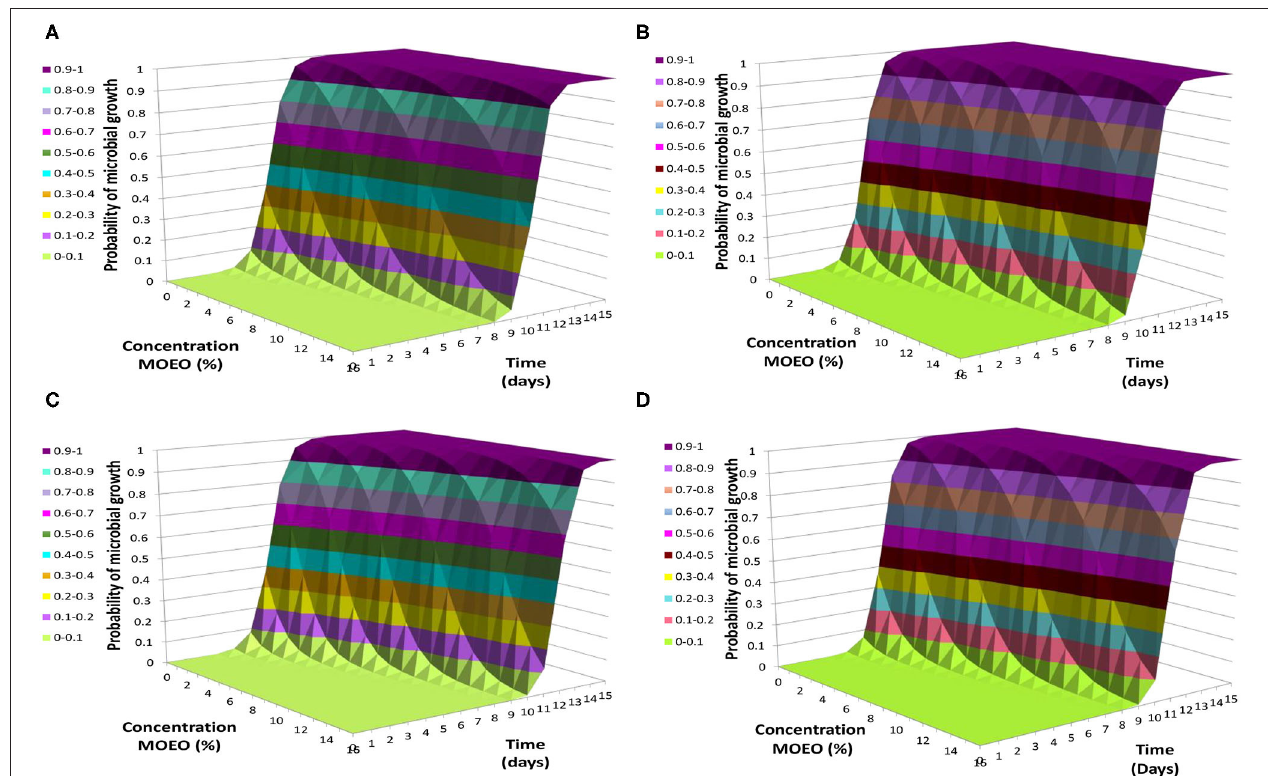
FIGURE 6 | Growth probability of Penicillium expansum (1.5 × 10 7 CFU/ml) when spraying emulsions at different concentrations of Mexican oregano essential oil (MOEO) on the surface of two bagel formulations with respect to time, obtained by applying the binary logistic regression model. Emulsion stabilized with pectin + bagel-wheat flour (A) ; emulsion stabilized with pectin + bagel-wheat flour-oats (B) ; emulsion stabilized with Arabic gum + bagel-wheat flour (C) ; emulsion stabilized with Arabic gum + bagel-wheat flour-oats (D)